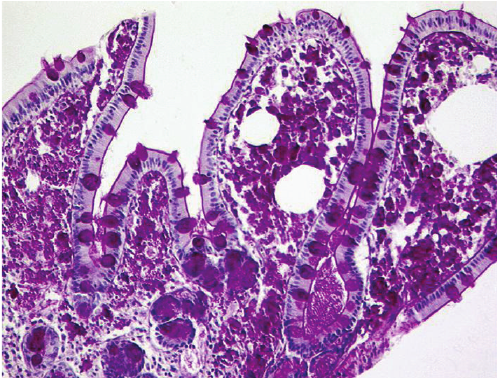
Figure 14: Whipple’s disease: intensely PAS-positive macrophages occupying the lamina propria mucosae. Goblet cells are positively stained, too. Brush border of enterocytes is also marked (as a deep purple line). PAS staining. Courtesy of Jan Noˇziˇcka, MD, PhD. Reproduced with permission from Bureˇs and Rejchrt [42].